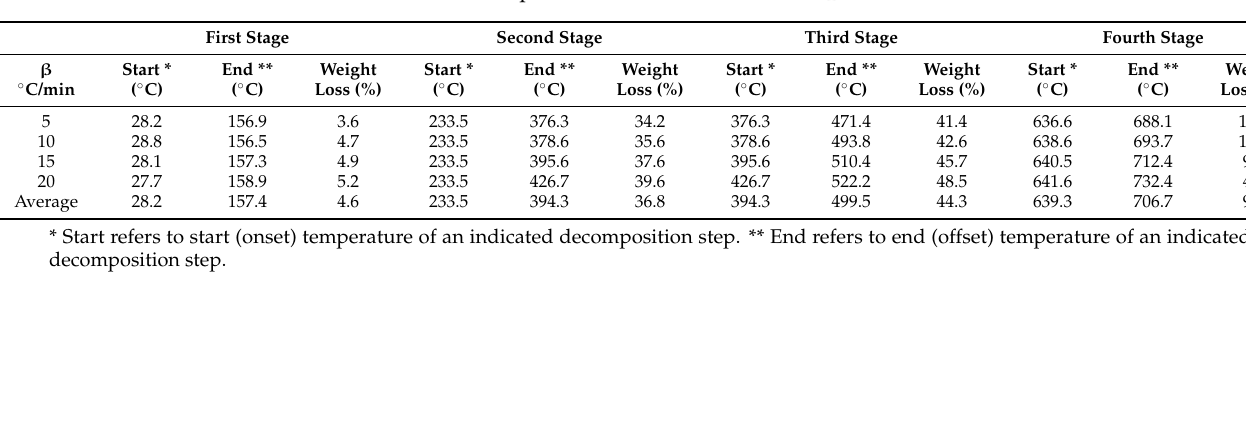
Table 2. Thermal decomposition of Subcoal™ PAF in N 2 from TGA